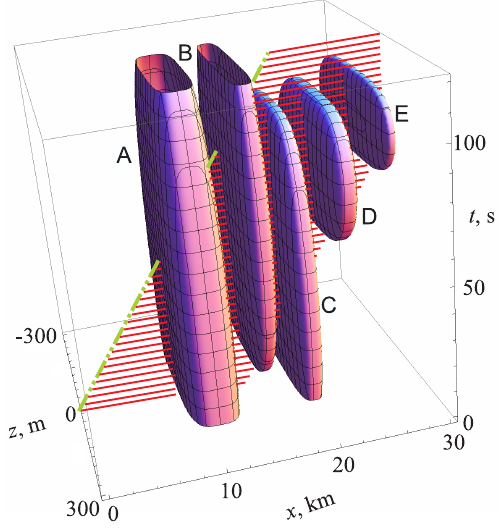
Figure 2. The 3-D images of aerosol clusters P(x,z,t) , calculated at 1 /e level, for the model given by Eq. (6). The dash-and-dot line is the flight trace; the red “comb” represents sensing laser pulses; L max = 16km; ϕ 0 =